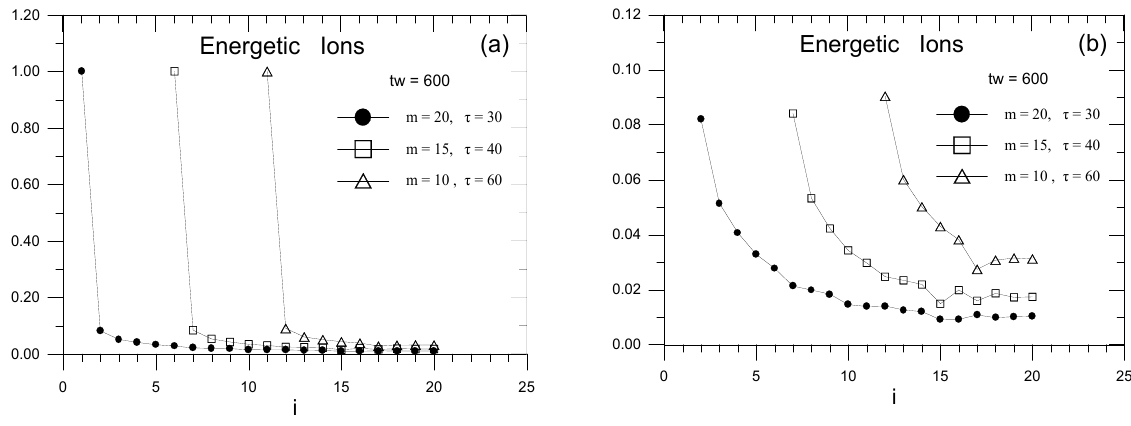
Figure 11 Fig. 11. (a) The spectra of singular values σ i , with parameter m = 10 , 15 , 20, estimated for the energetic ions time series. (b) The same